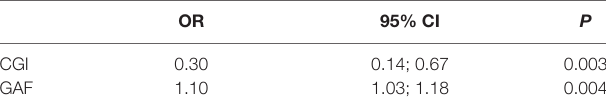
TABLE 3 | Bivariate predictors of short (≤3 months) versus long-term (>3 months) employment (n = 67). OR 95%